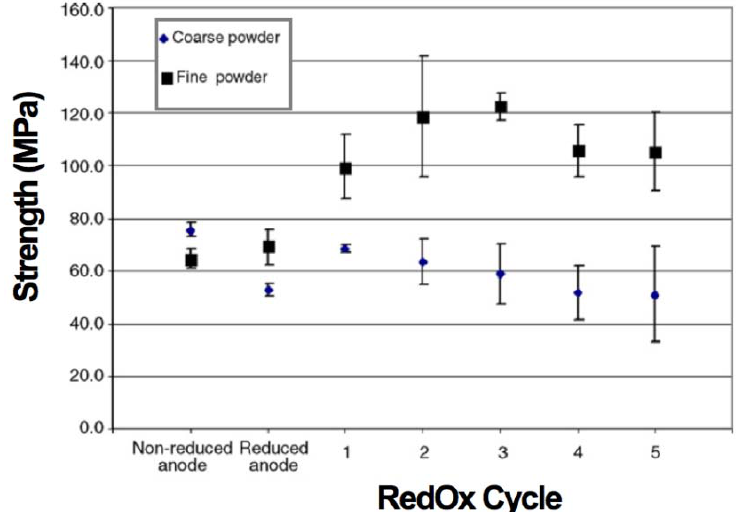
Figure 10. Strength of the C-shaped uniaxial compressed anode rings versus number of RedOx cycles. The samples were fabricated using two different powders, coarse green NiO and fine black nickel oxide